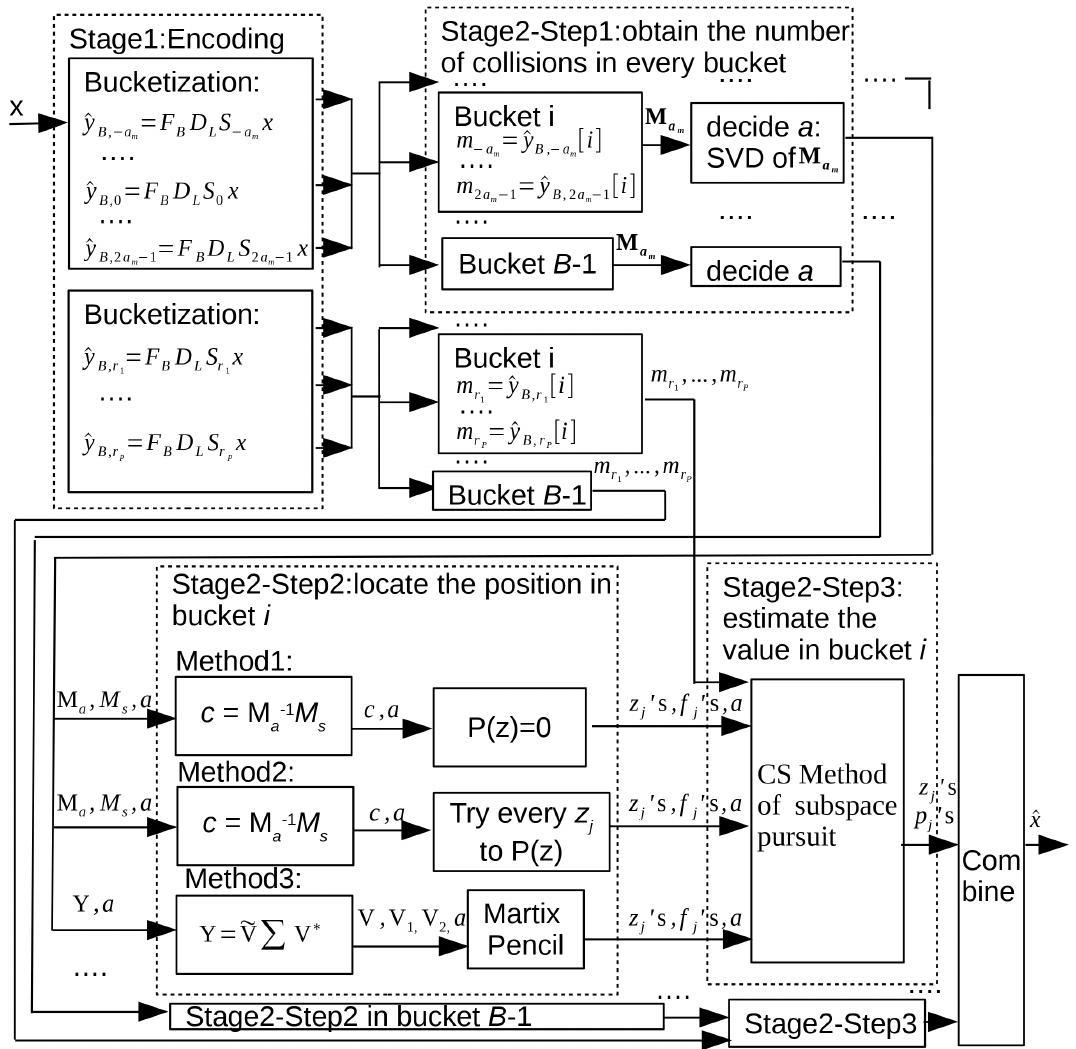
Figure 1. A system block diagram of the one-shot